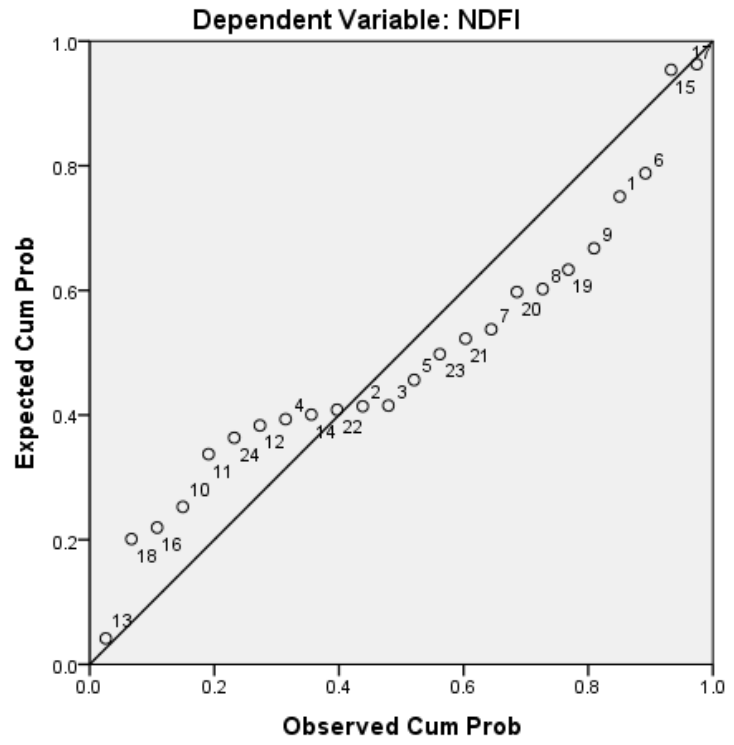
Figure 48. The normal p–p plot of regression ZRE.